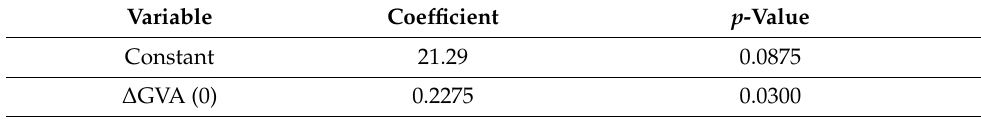
Table A3. ARDL results for Latvia after sequentially omitting insignificant